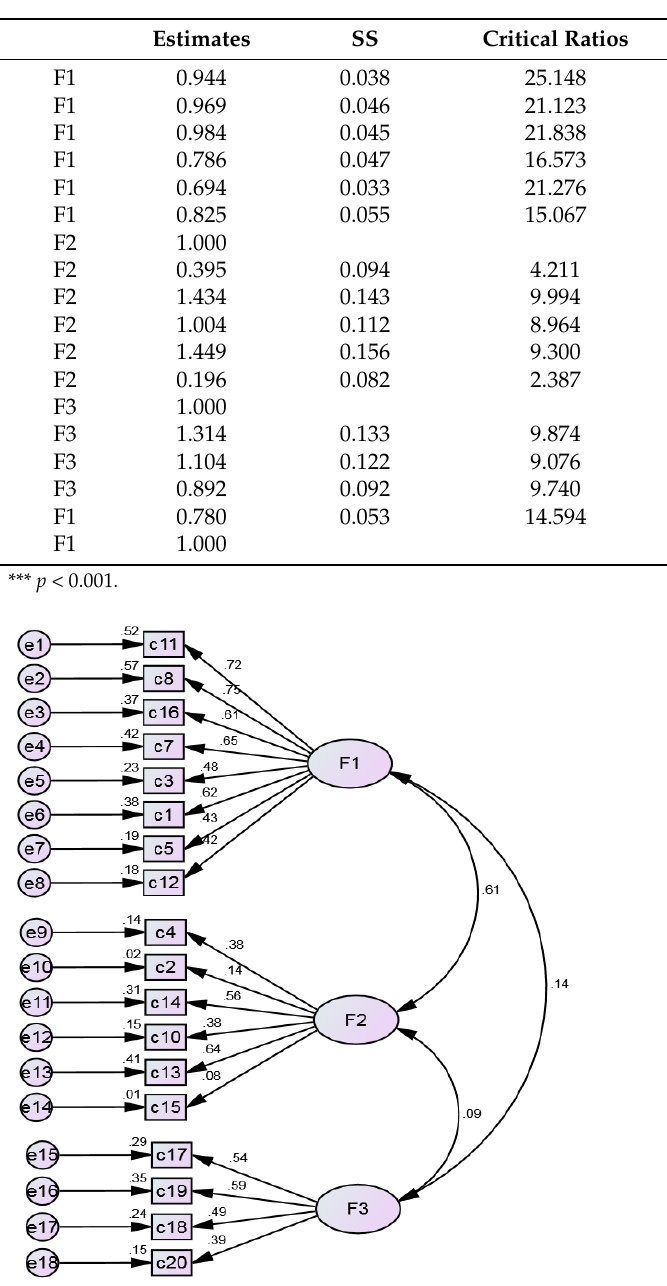
Table 3. Trajectories, critical ratios and lambda coefficients.